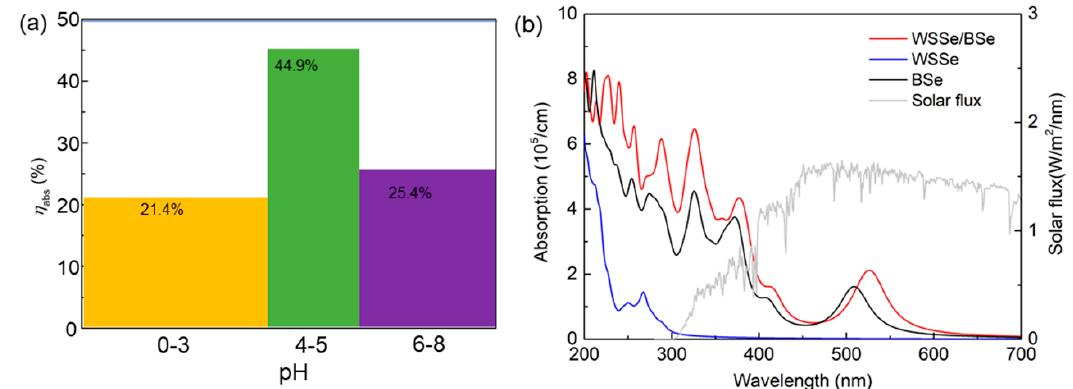
Figure 7. The calculated ( a ) STH efficiency at different pH values and ( b ) optical absorption of the WSSe/BSe vdW heter ‐ ostructure.